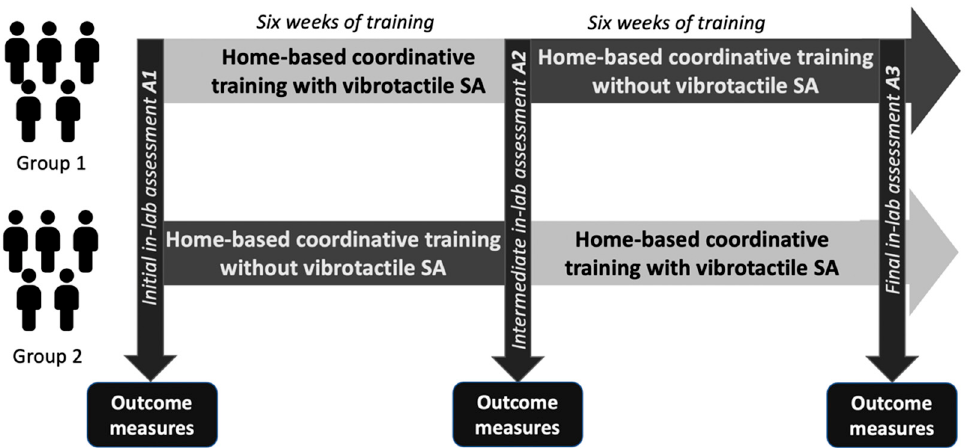
Figure 1. Schematic illustrating the 2 × 2 crossover experimental design used in this study. Partici- pants followed a home-based balance and coordination training program for 12 weeks split into two six-week blocks. Following an initial laboratory-based performance assessment (A1), participants were split into two groups. Group 1 performed home-based training with vibrotactile SA for the first six weeks then trained without vibrotactile SA for the following six weeks. Group 2 performed home-based training without vibrotactile SA for the first six weeks then trained with vibrotactile SA for the following six weeks. After each block of six weeks, participants’ balance and coordination were assessed halfway through (A2) and at the end (A3) of the 12-week intervention.